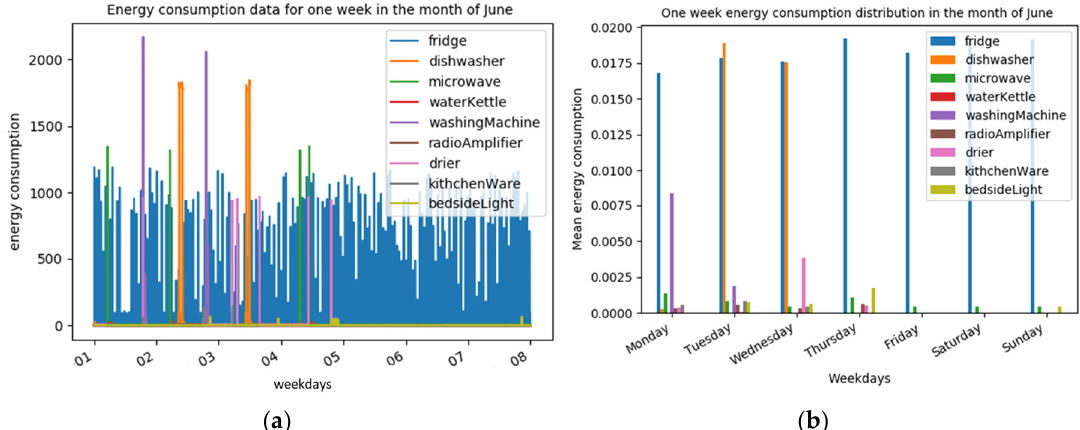
Figure 11. ( a ) Home building energy consumption data processing and analysis with respect to each appliance for the period of eight days in the month of June ( b ) Mean energy utilization distribution and comparison in the weekdays